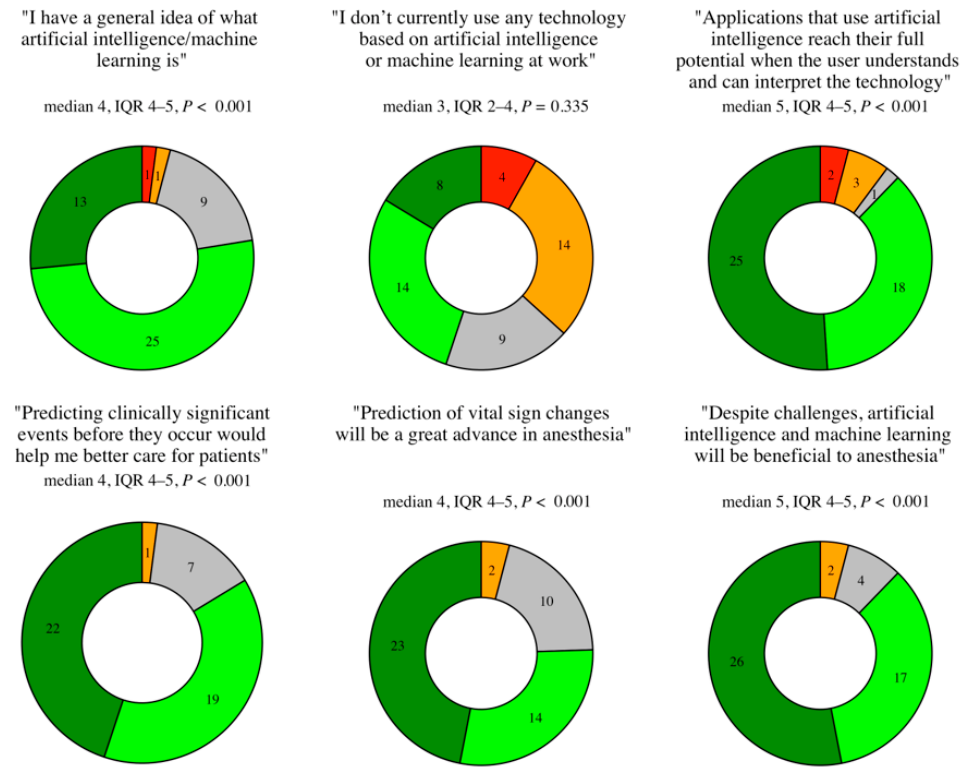
Figure 2. Part two survey results as donut diagrams of the number of responses per rating on a five-point Likert scale, and with medians, interquartile ranges, and p -values (strongly disagree = 1, dis- agree = 2, neutral = 3, agree = 4, strongly agree = 5). n = 49.